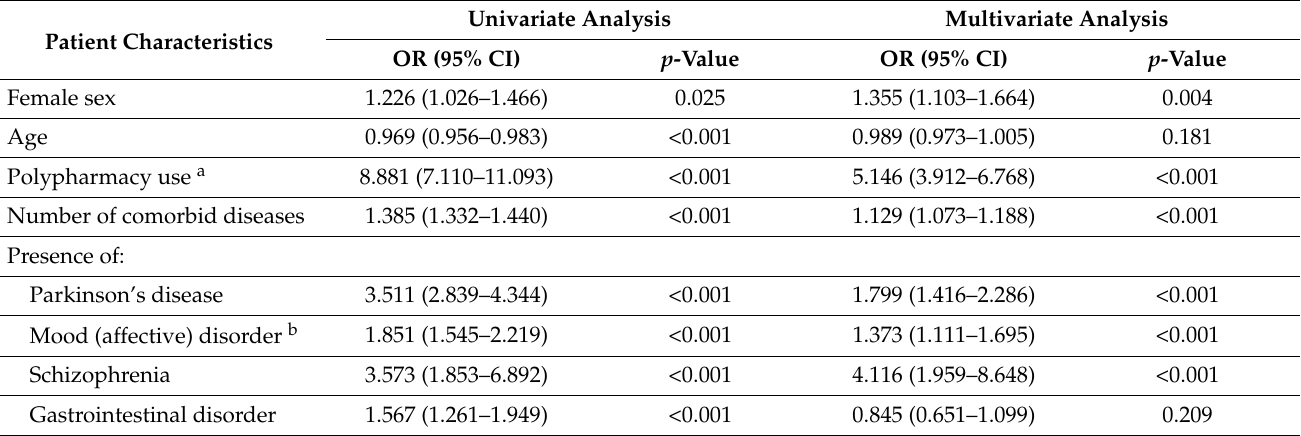
Table 4. Univariate and multivariate analyses for the association between DPIM use and patient